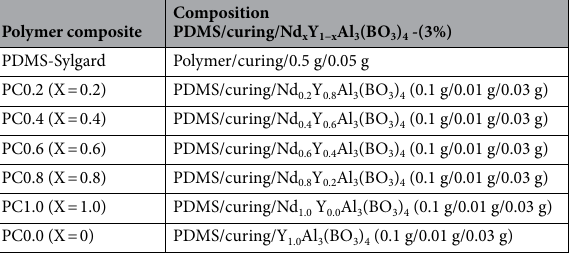
Table 1. Composition of the polymer composite with Nd:YAB